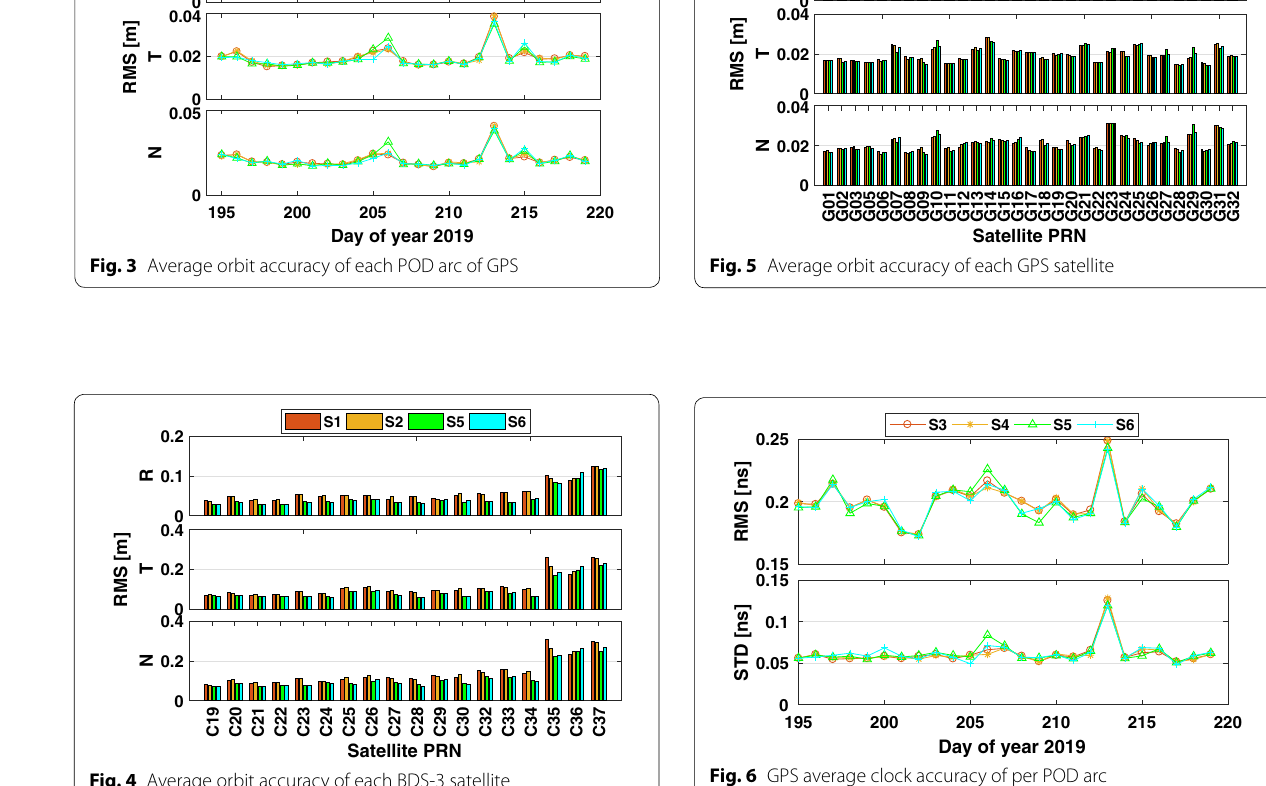
Fig. 4 Average orbit accuracy of each BDS-3 satellite